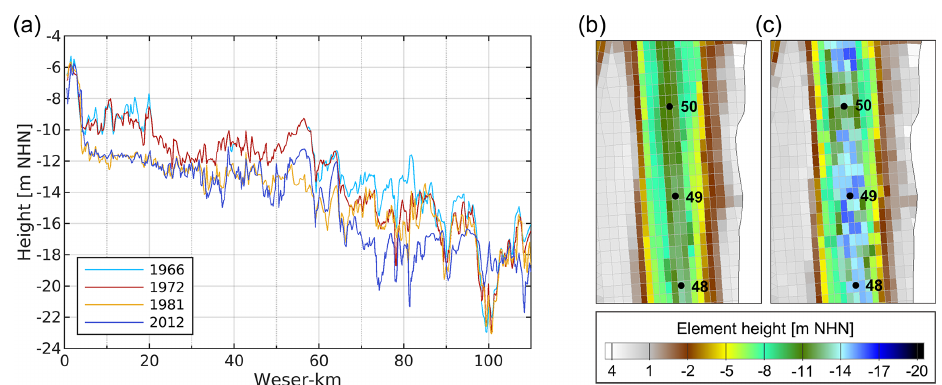
Figure 2. Height along the navigation channel (200–300m width) in the Weser estuary in different years, based on model topographies (a) . Element height in a section of the Lower Weser of model topographies 1972 (b) and 2012 (c) . Notations 48, 49, and 50 in (b) and (c) mark the position (Weser-km) along the navigation